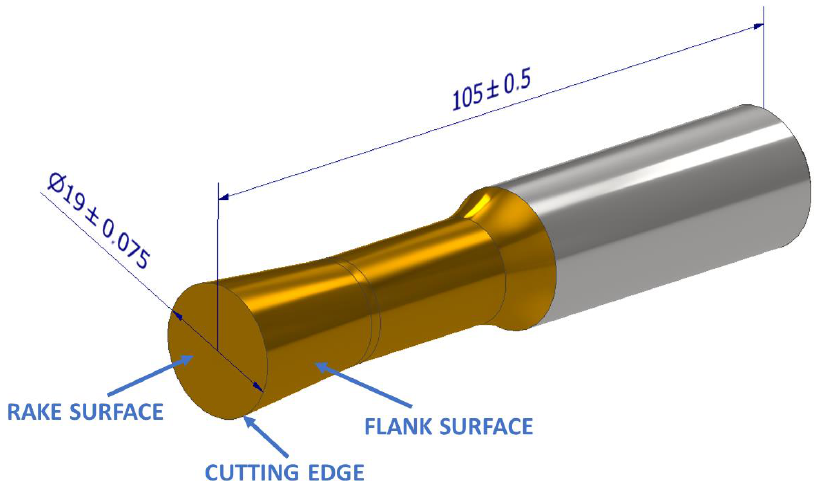
Figure 2. Model and basic dimensions (mm) of a monolithic rotary tool.